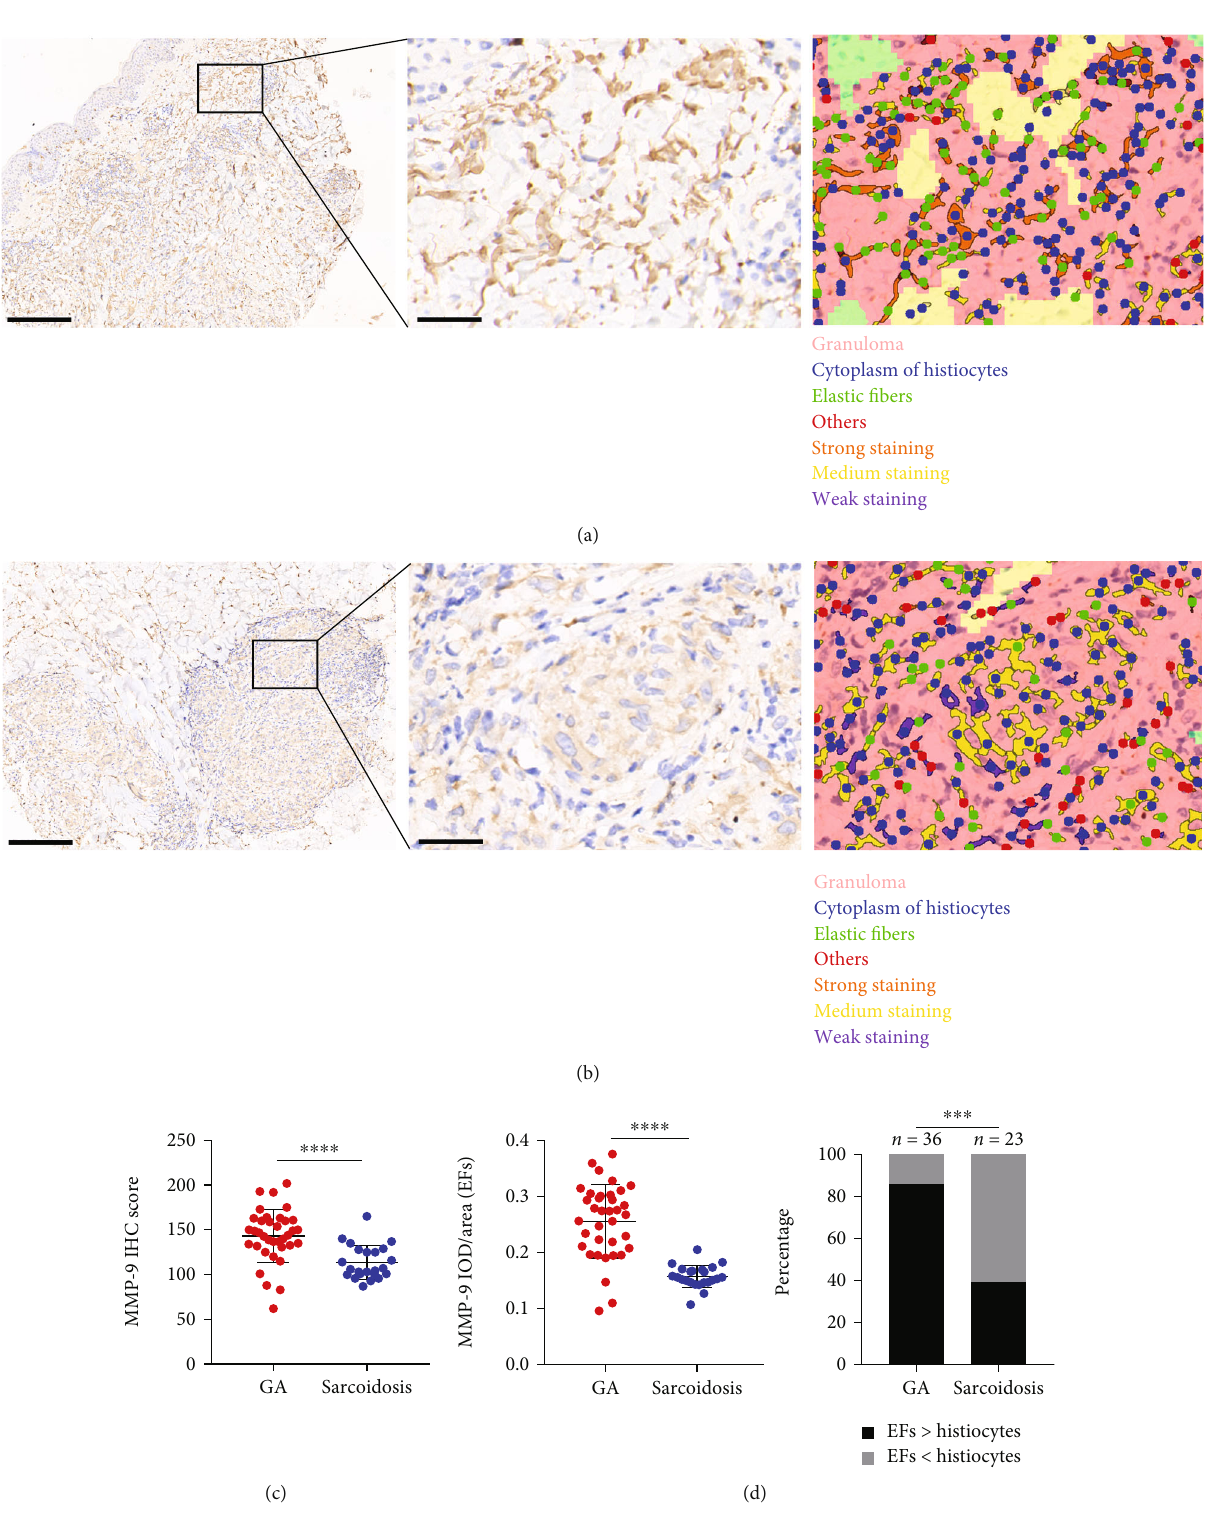
Figure 2: MMP-9 expression in granuloma annulare and sarcoidosis biopsies. (a) IHC staining and segmentation of biopsy section of patients with GA, the high-power photo shows that MMP-9 predominantly stain the elastic fi bers (EFs) in GA biopsy. (b) IHC staining and segmentation of biopsy section of patients with sarcoidosis, the high-power photo shows that MMP-9 predominantly stains the histiocytes in sarcoidosis biopsy. Lower-power photo, scale bar = 250 μ m ; high-power photo, scalebar = 40 μ m . (c) Quanti fi cation of IHC staining for MMP-9 in patients with GA and sarcoidosis. (d) Quanti fi cation of IHC staining for MMP-9 in EFs in patients with GA and sarcoidosis. MMP-9 is mainly expressed in EFs in GA while histiocytes in